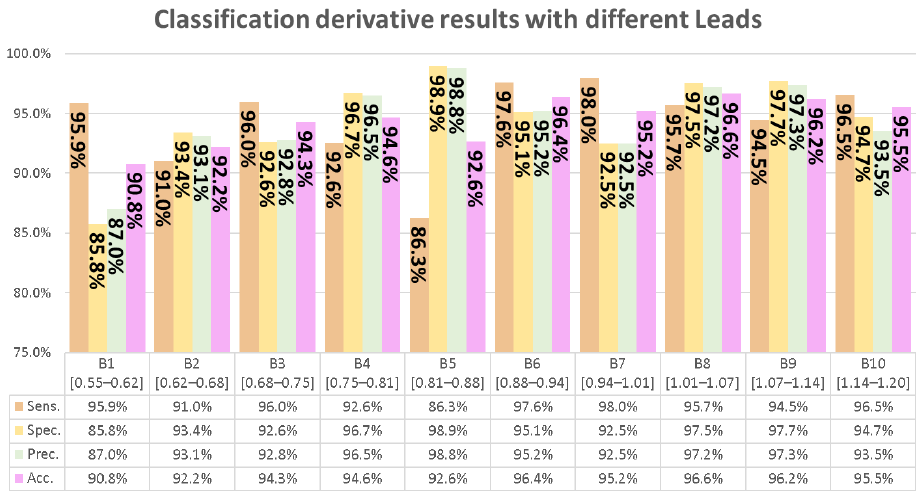
Figure 10. Combined leads classification